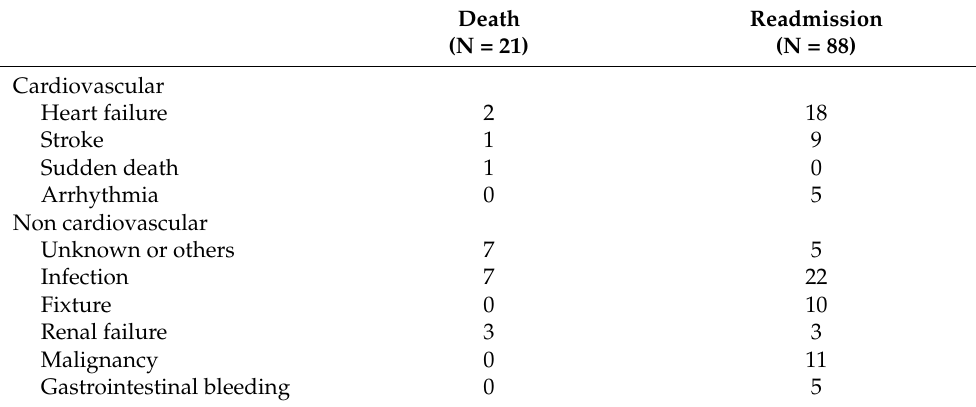
Table 2. Causes of death or readmission.